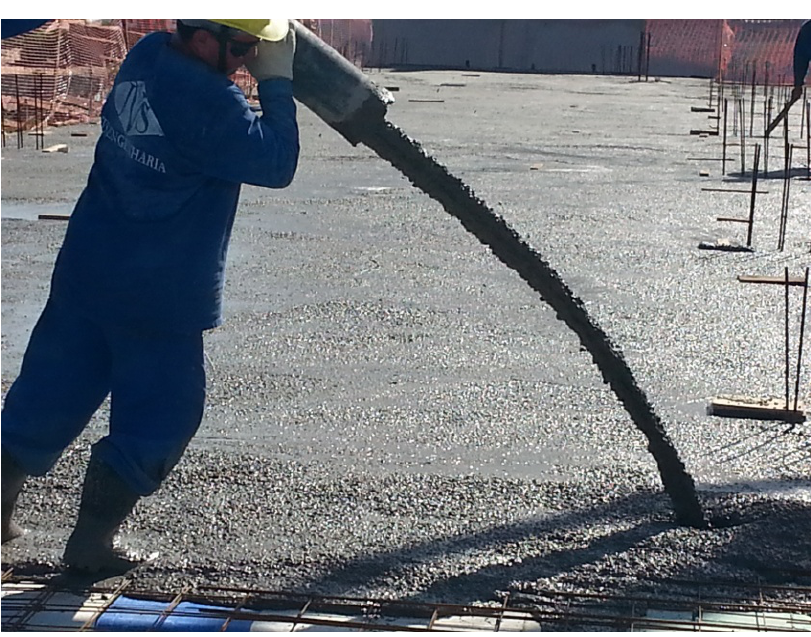
Figure 4. SCC pouring in the site.